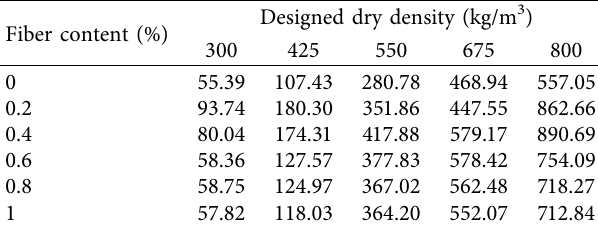
Figure 12: Schematic diagram of fiber distribution in cast-in-situ foamed concrete slurry. (a) Glass fiber. (b) Polypropylene fiber. Table 5: Elastic modulus results of cast-in-situ foamed concrete with glass fiber (unit: MPa).